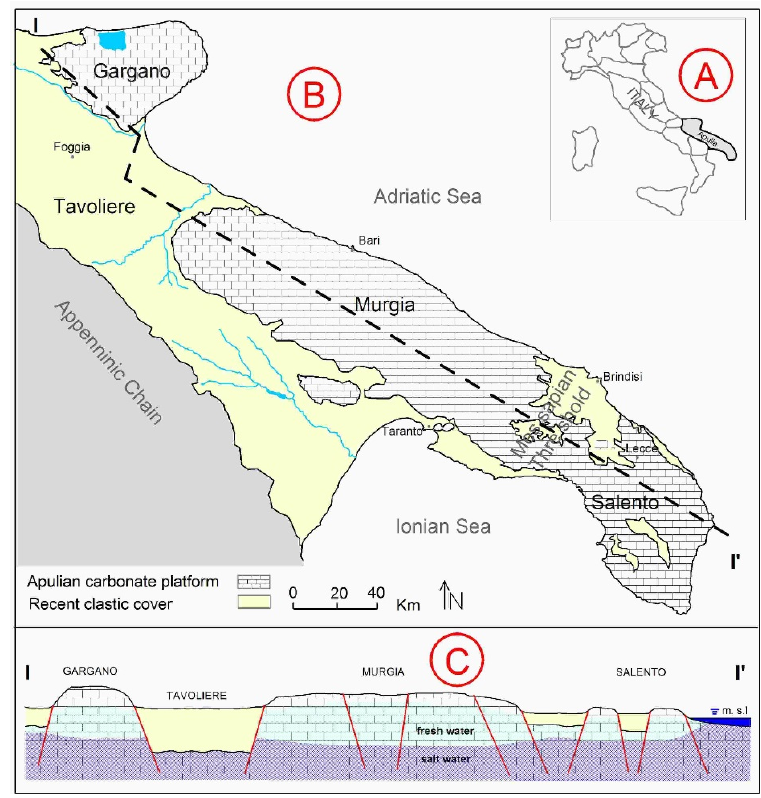
Figure 3. Apulian simplified geological scheme and hydrogeological structures (after [18,19]). ( A ) Apulia together with the other Italian regions; ( B ) geological scheme and hydrogeological structure map (light blue is used for surface water); ( C ) schematic section (note: not to scale; faults are plotted with red lines; fresh and salt groundwater are schematically distinguished by light blue and light violet shading, respectively).